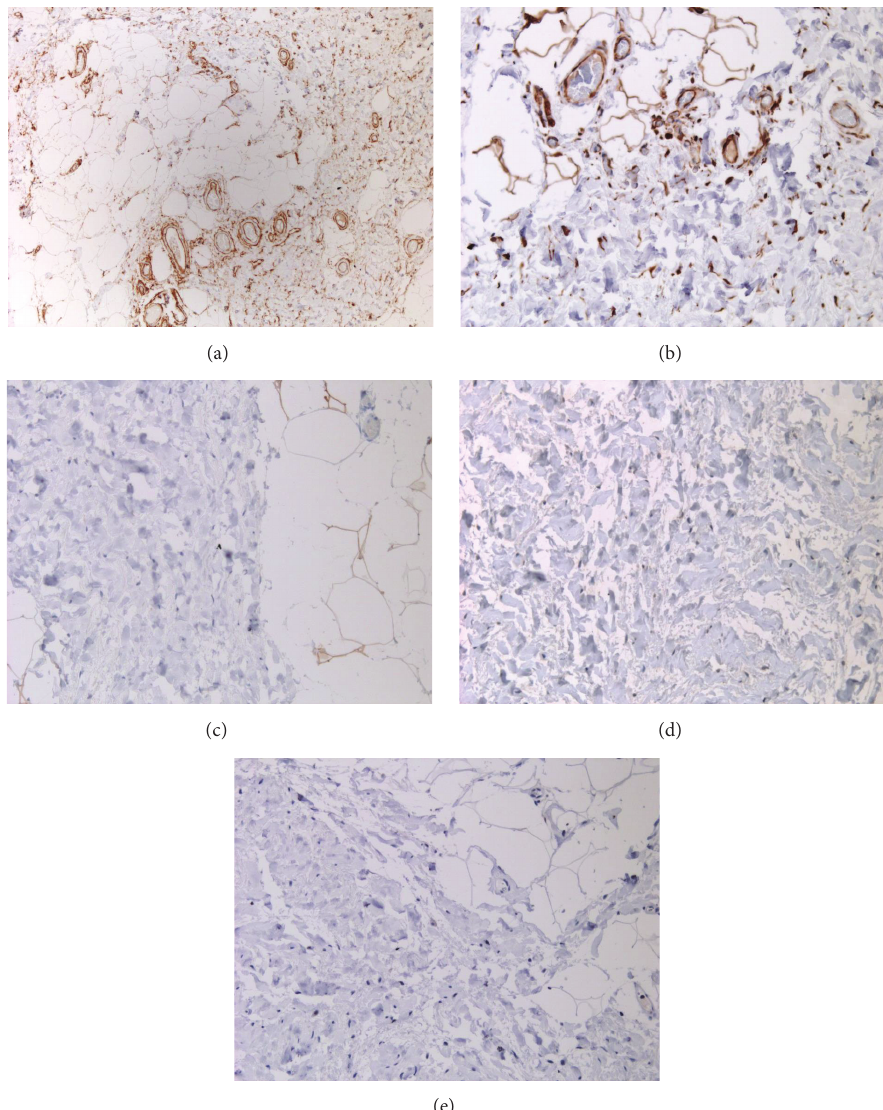
Figure 3: Reactive lobular vascular proliferation, highlighted by CD31 ((a), 10x). The stromal cells are positive for vimentin ((b), 20x) and negative for S-100, MDM2, and p16 ((c)–(e), all